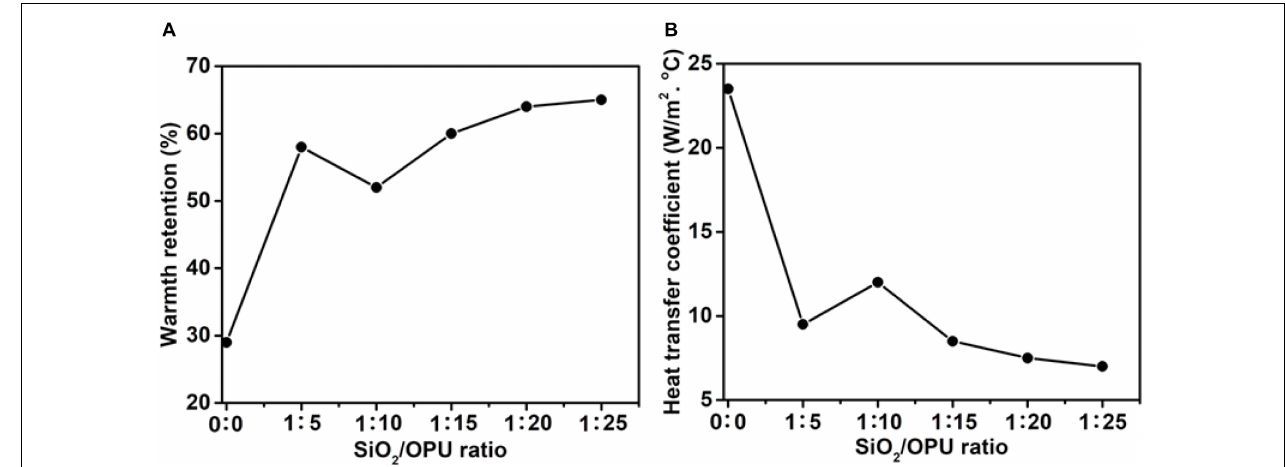
FIGURE 4 | Warmth retention (A) and heat transfer coefficient (B) of OPU/SiO 2 aerogel.